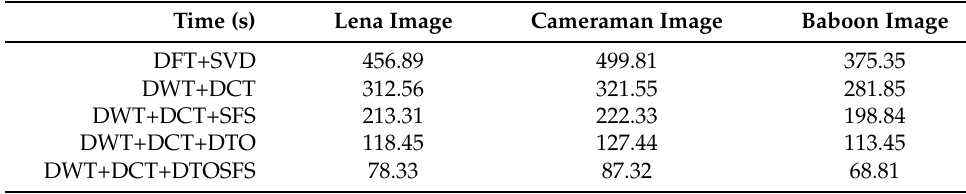
Table 8. The recovery time of the Monkeypox image in